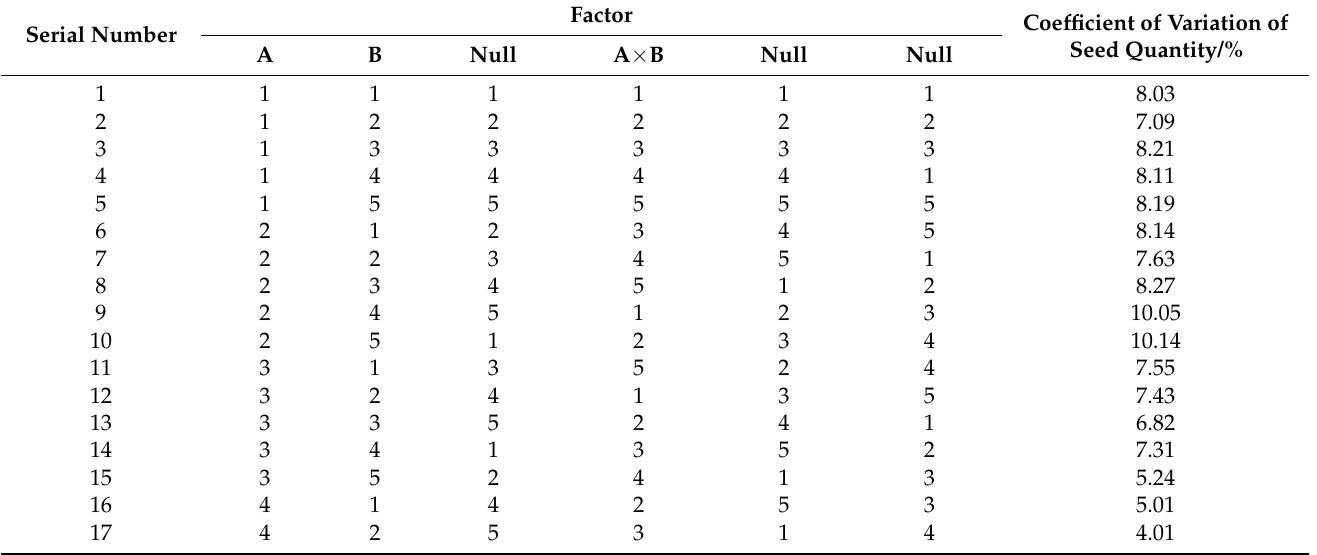
Table 5. Test design scheme and